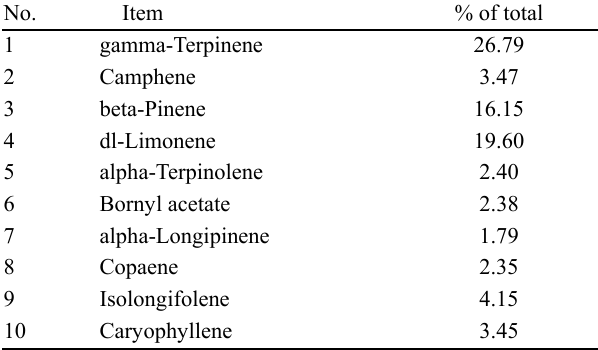
Table 2. Major composition of terpenes in phytoncide oil 1 No.